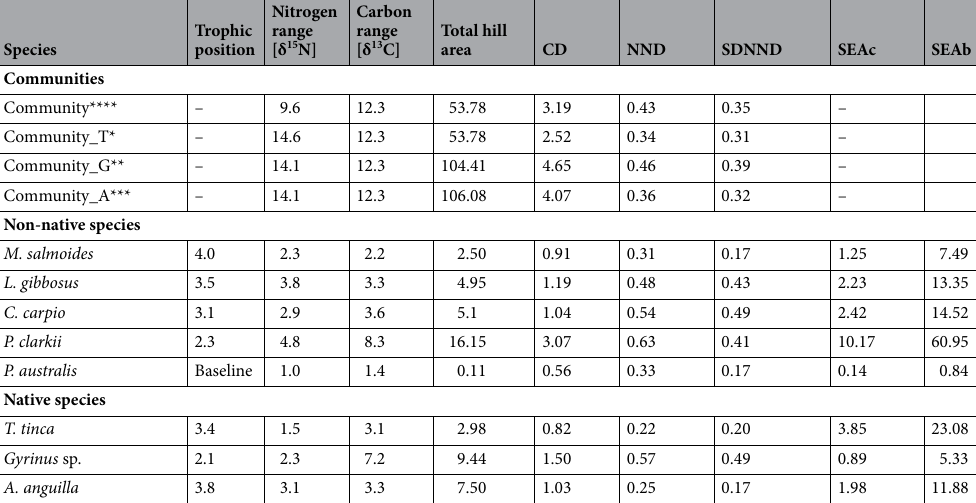
Table 2. Layman metrics for all species and the assumed present T. tinca, Gyrinus sp. , and A. anguilla as well as the community with and without them. CD mean distance to centroid, NND mean nearest neighbour distance, SDNND standard deviation of the nearest neighbour distance, SEAc corrected Standard Ellipse Area considering 40 % data coverage, SEAb corrected Standard Ellipse Area considering 95 % data coverage. * Under consideration of T. tinca being present in Arreo Lake. ** Under consideration of Gyrinus sp. being present in Arreo Lake. *** Under consideration of A. anguilla being present in Arreo Lake. **** Under consideration of neither T. tinca nor Gyrinus sp. being present in Arreo